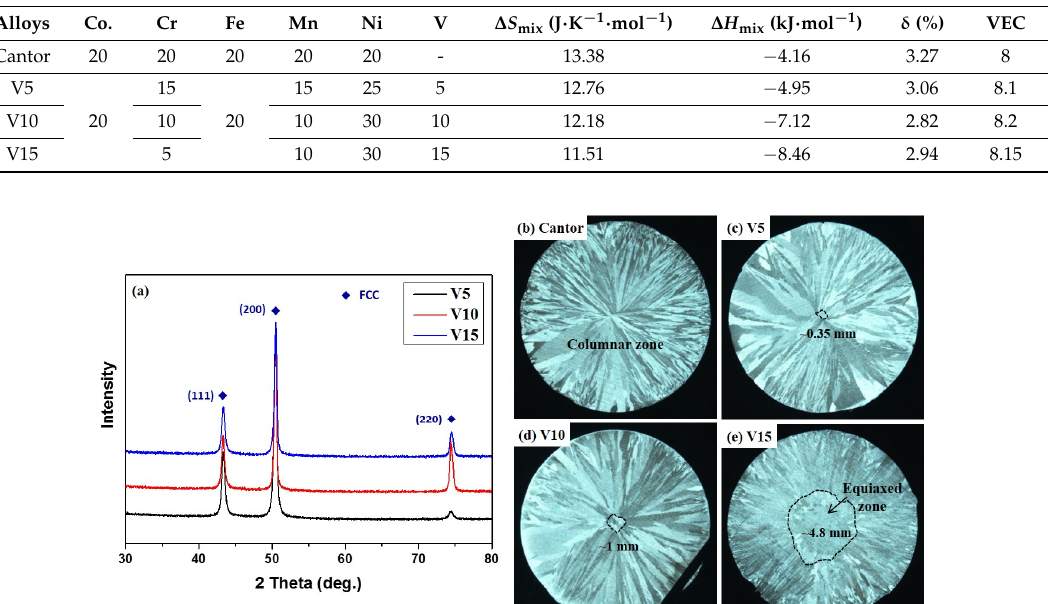
Table 3. Chemical compositions (at %) and entropy, enthalpy, atomic size difference, and valence electron concentration of HEAs used in this work.